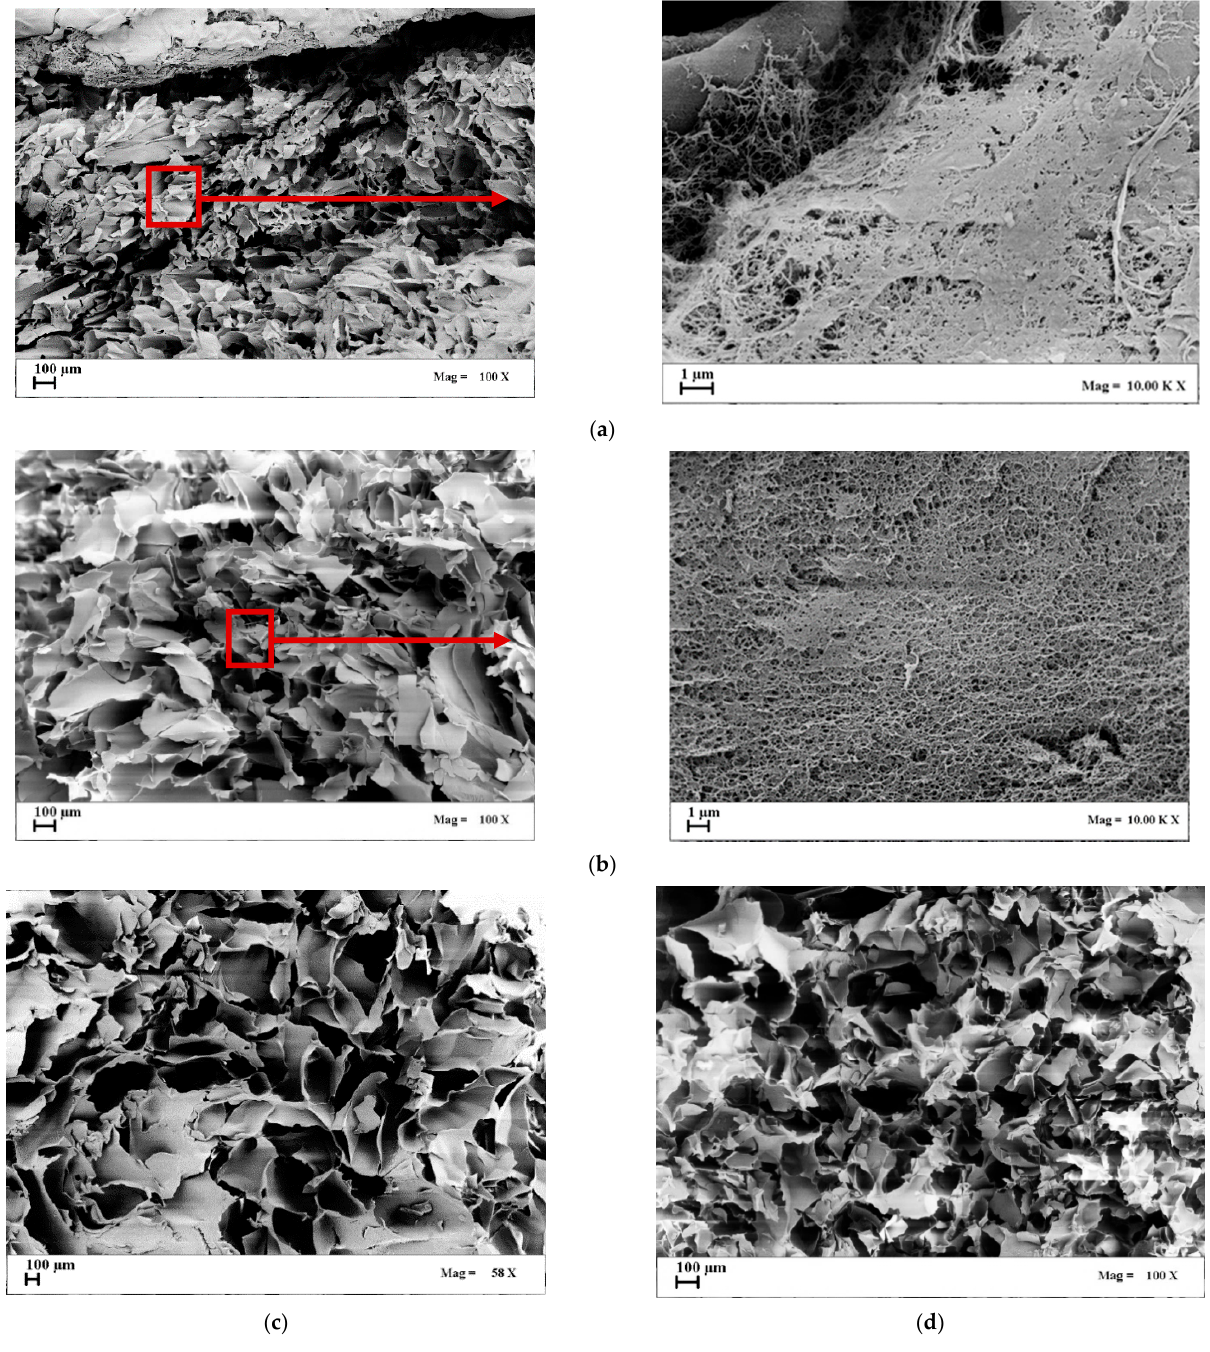
Figure 2. SEM images of cryogels section obtained by a fast-cooling step: ( a ) 1 wt% agarose; ( b ) 3 wt% agarose; ( c ) 5 wt% agarose; ( d ) 8 wt% agarose.